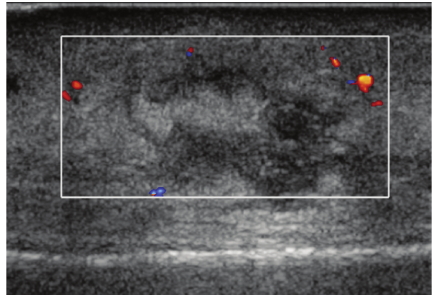
Figure 1: Ultrasound doppler 14 days after trauma. The investiga- tion was targeted to the distal part of the shin. A complex process is seen in the subcutaneous fat with hyper- and hypoechoic regions and unclear boundaries without increased blood flow and without periosteal reaction.